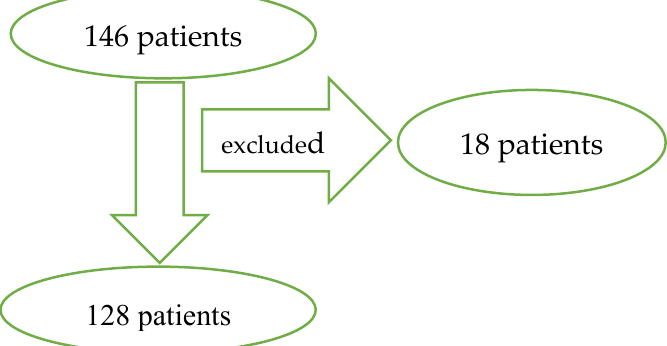
Figure 1. 146 extra-axial hematoma patients required surgical treatment. Exclusion criteria included: the lack of complete medical documentation, incomplete laboratory tests, the lack of description of the computed tomography, lack of contact with the patient or his family after 6 months, and the occurrence of injuries other than head injury. At least 18 patient were excluded and 128 patient met inclusion criteria.